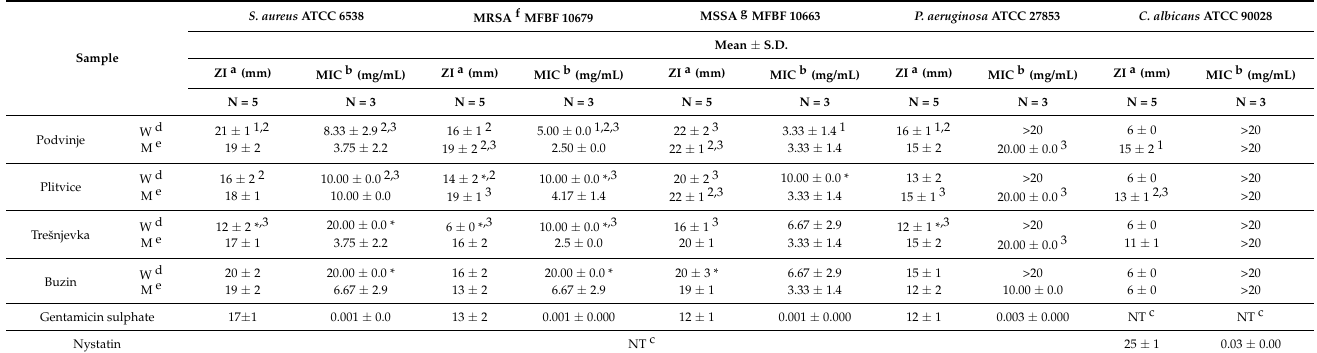
Table 2. In vitro antimicrobial activity screening of E. cicutarium water and methanolic extracts from four locations in Croatia (Podvinje, Plitvice, Trešnjevka, Buzin), for the agar well diffusion assay and the microdilution broth